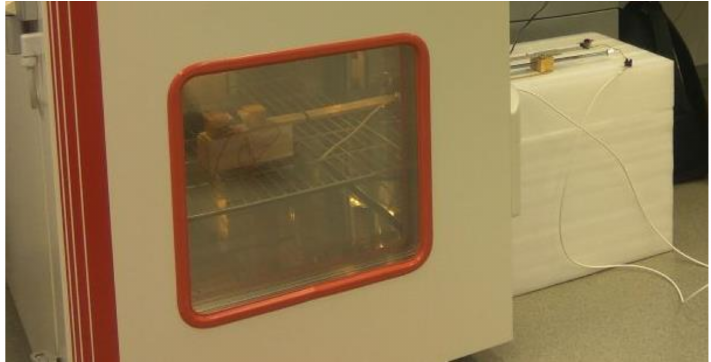
Figure 3. Test equipment placed in an air-conditioning chamber during experimental testing.